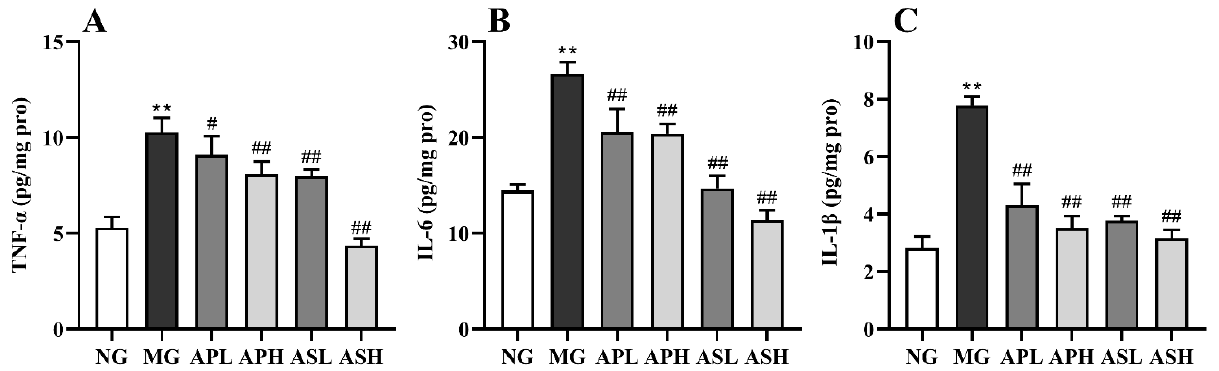
Figure 5. Effect of AP and AS on inflammation response in ALD mice. ( A ) Hepatic IL-1β; ( B ) Hepatic IL-6; ( C ) Hepatic TNG-α. Data are expressed as mean ± SD ( n = 12). ** p < 0.01, vs. NG; # p < 0.05, ## p < 0.01, vs. MG.